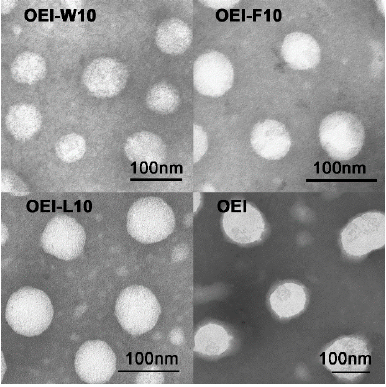
Figure 4. TEM image of polyplexes at certain weight ratio ( w / w = 16:1 for OEI-W10&OEI-L10 and w/w = 24:1 for OEI-F10&OEI) in deionized water.